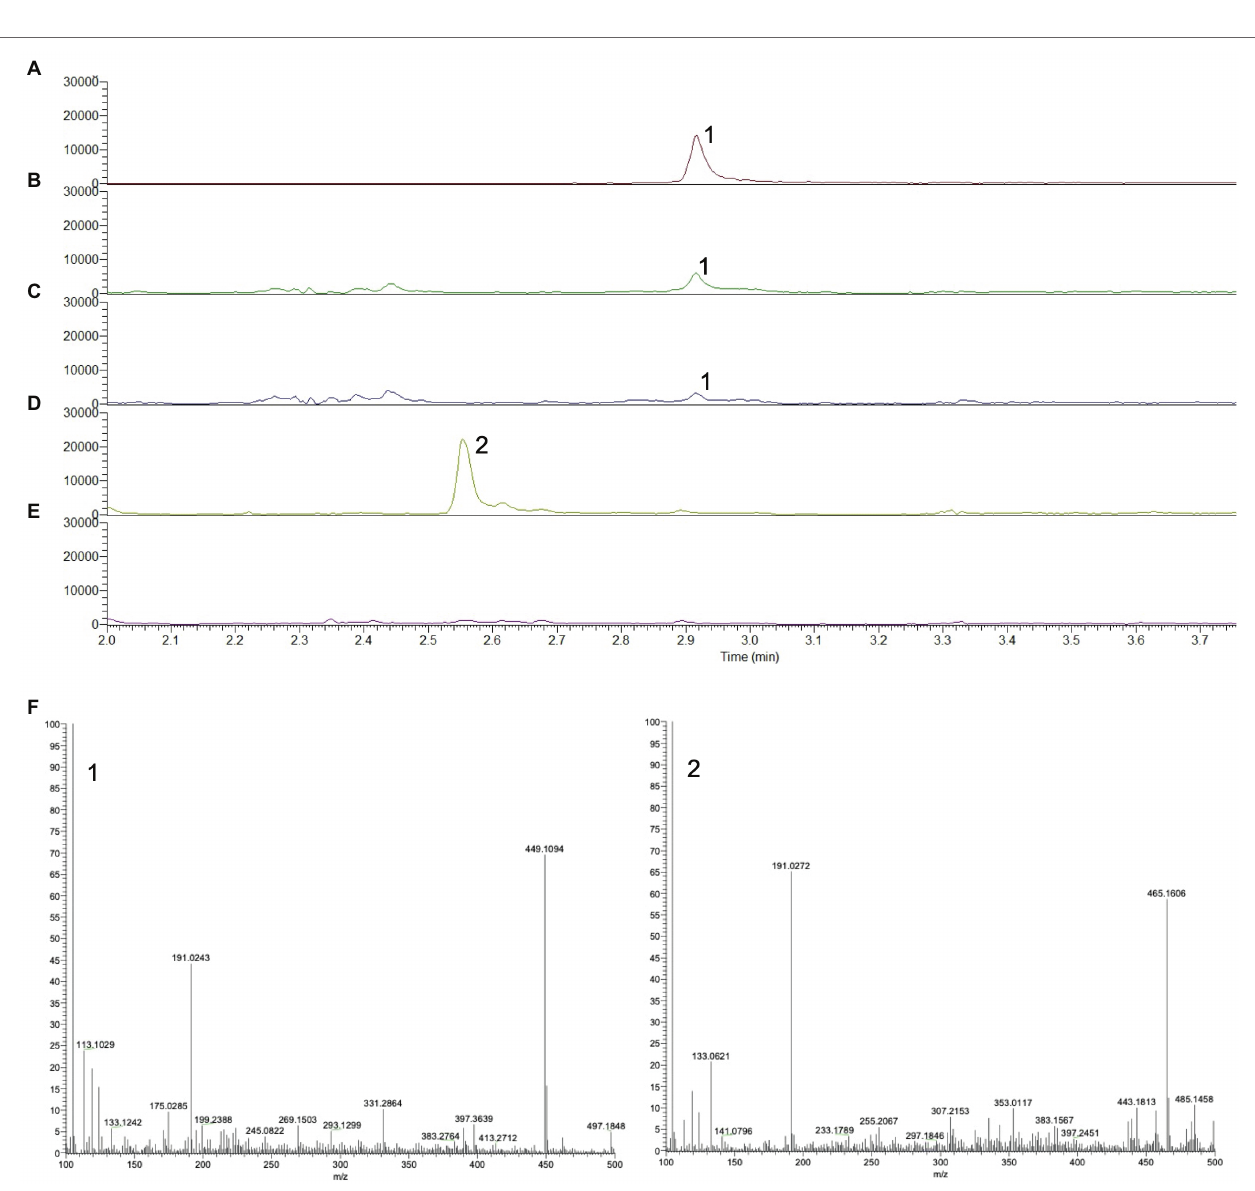
FIGURE 3 | UPLC-MS chromatograms showing the prenyl diphosphate profile of N. benthamiana infiltrated with different diterpene precursor genes. (A) Authentic standard of GGPP, m/z 449–450. (B) Co-expression of DXS + GGPPS, m/z 449–450. (C) Co-expression of DXS + HDR + GGPPS , m/z 449–450. (D) Co-expression of DXS + GGPPS , m/z 465–466. (E) Co-expression of DXS + HDR + GGPPS , m/z 465–466. (F) Mass spectrum of GGPP (1) and putative OH-GGPP